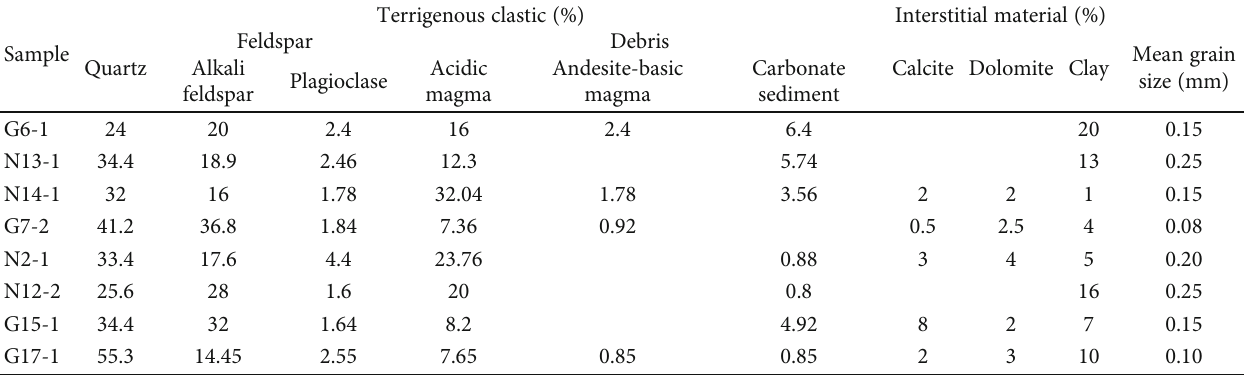
Table 7: Determination of the main mineral compositions in sandstone slice.